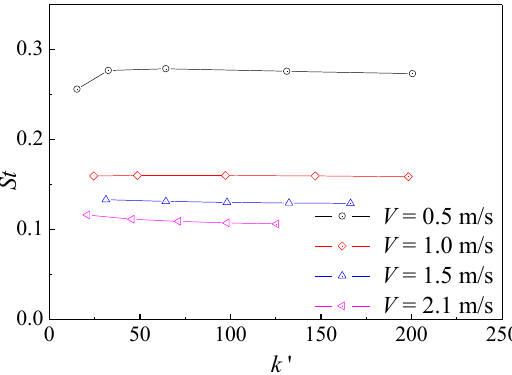
Figure 17. St number of bow foil at different speeds and different spring stiffness in this paper.